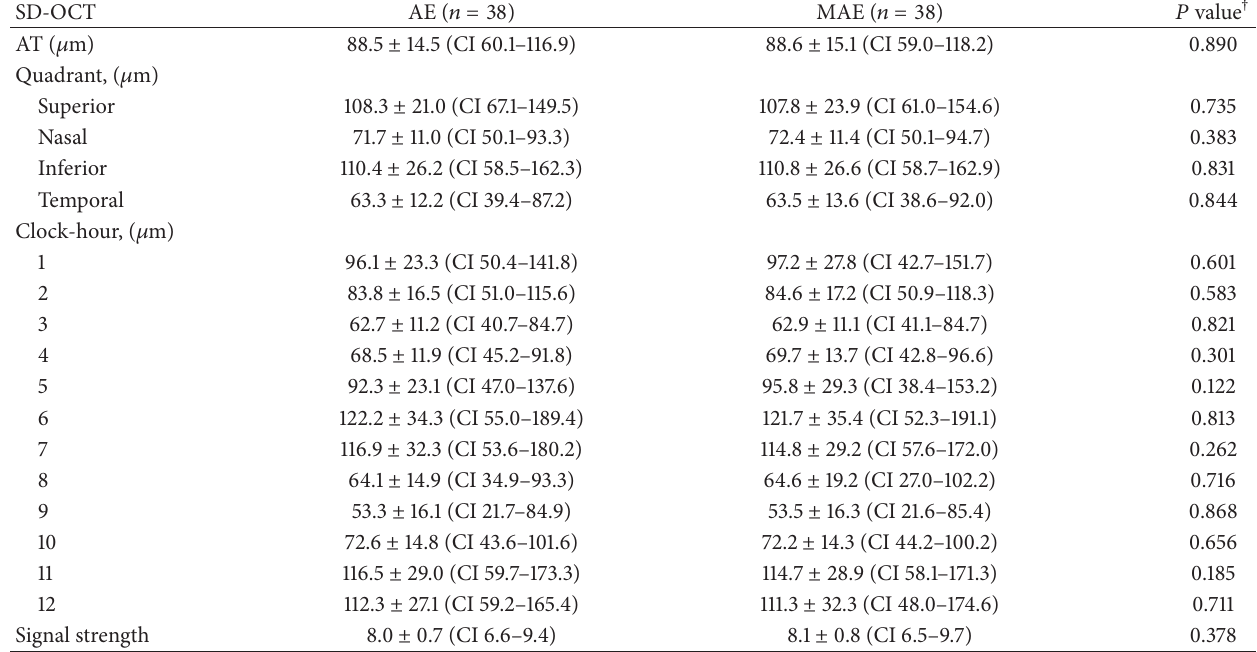
Table 5: Comparison of mean ± standard deviation (95% confidence interval) SD-OCT parameters between eyes with and without misalignments within the measurement ring (sectors 2 and